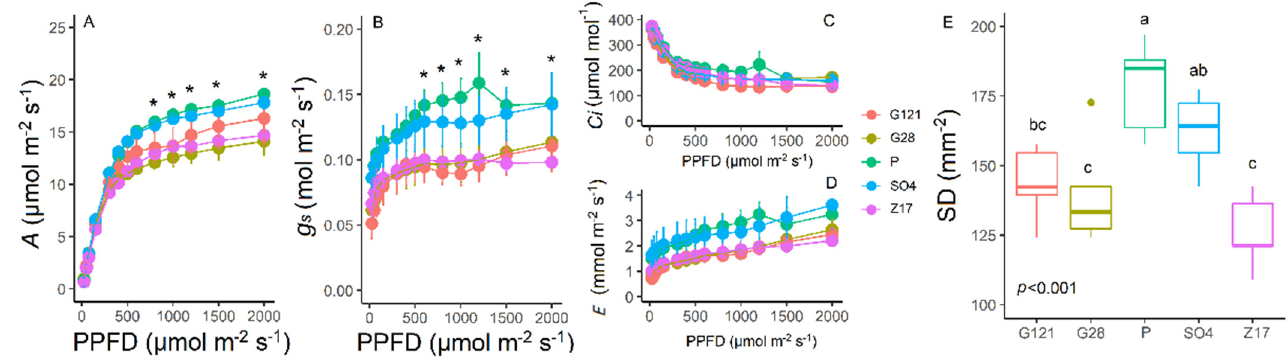
Figure 2. Light (PPFD) response curves for Pinot gris grafted on five rootsotcks measured under optimal environmental conditions ( n = 4). ( A ) CO 2 assimilation rate ( A ), ( B ) stomatal conductance ( g s ), ( C ) sub-stomatal CO 2 concentration ( C i ), ( D ) transpiration rate ( E ) measured at of 400 μ mol mol − 1 ambient CO 2 concentration, leaf temperature of 25 °C and VPD of between 1 and 1.5 kPa (values are means ± standard error of the means). Asterisks show significant differences ( p < 0.05) between rootstocks according to one-way ANOVA. In ( E ), leaf stomatal density (SD) is shown ( p < 0.001). Different letters represent significant differences according to Fisher’s test.